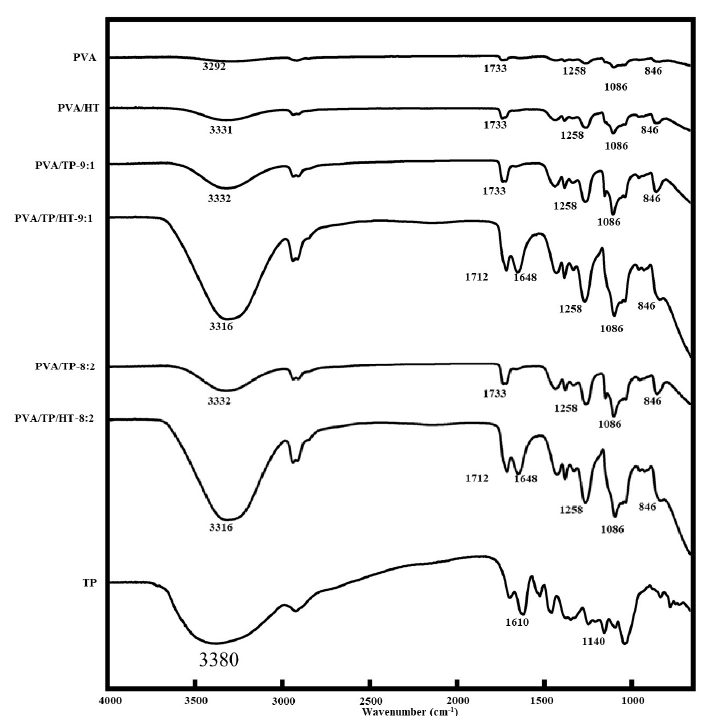
Figure 3. Fourier transform infrared (FTIR) spectra of PVA, PVA/HT, PVA/TP-8:2, PVA/TP/HT-8:2, PVA/TP-9:1, PVA/TP/HT-9:1, and TP nanofiber films.